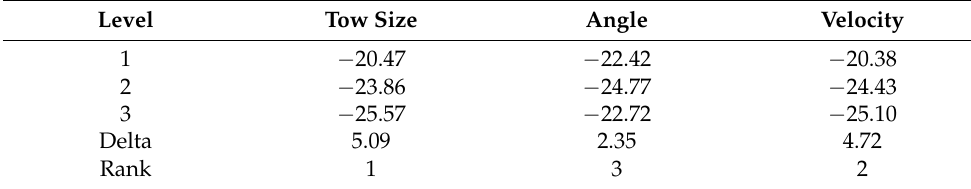
Figure 4. Main effect plot of the S/N ratio for erosion rate. Table 5. Response table for erosion rate.